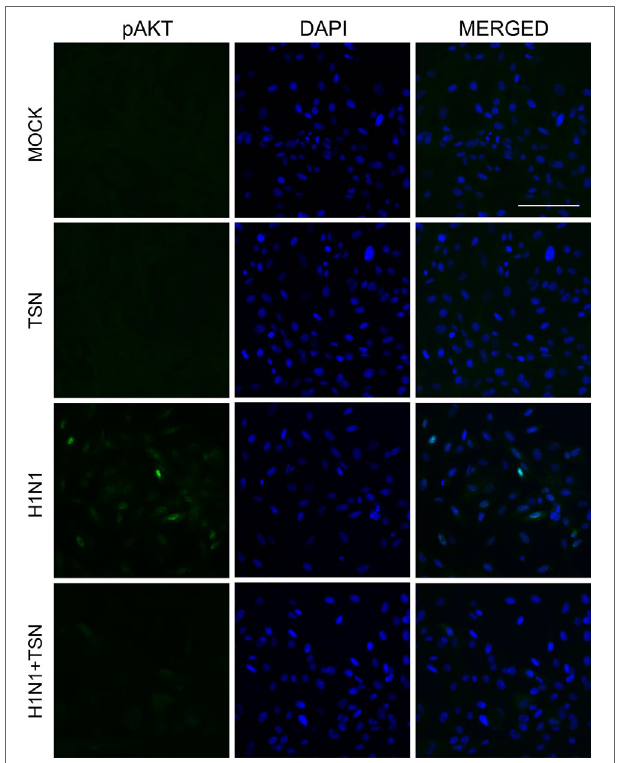
FIGURE 9 | Oral administration of TSN protected Balb/c mice from influenza A virus-induced death. (A and B) TSN (1 mg/kg) was orally administered to Balb/c mice daily for 8 days before intranasal infection with mouse- adapted A/PR/8/34 at 5× LD 50 . The survival rate (A) and body weight (B) of uninfected mice (CON, n = 5), vehicle-treated infected mice (H1N1, n = 10), and TSN-pretreated infected mice ( n = 10 at each dose, 1 mg/kg per day for 7 days) were monitored for 17